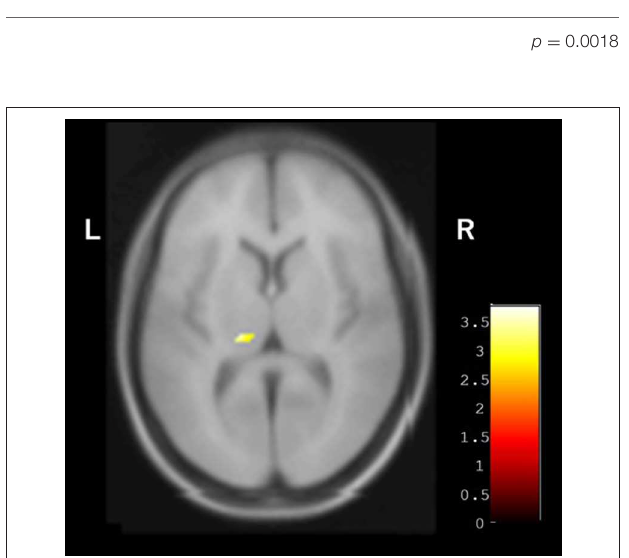
FIGURE 4 | VBM analysis showing the difference between groups with and without pulvinar hypointensity in SWI. Left pulvinar volumes of the group with pulvinar hypointensity in SWI were smaller than those of the group without pulvinar hypointensity in